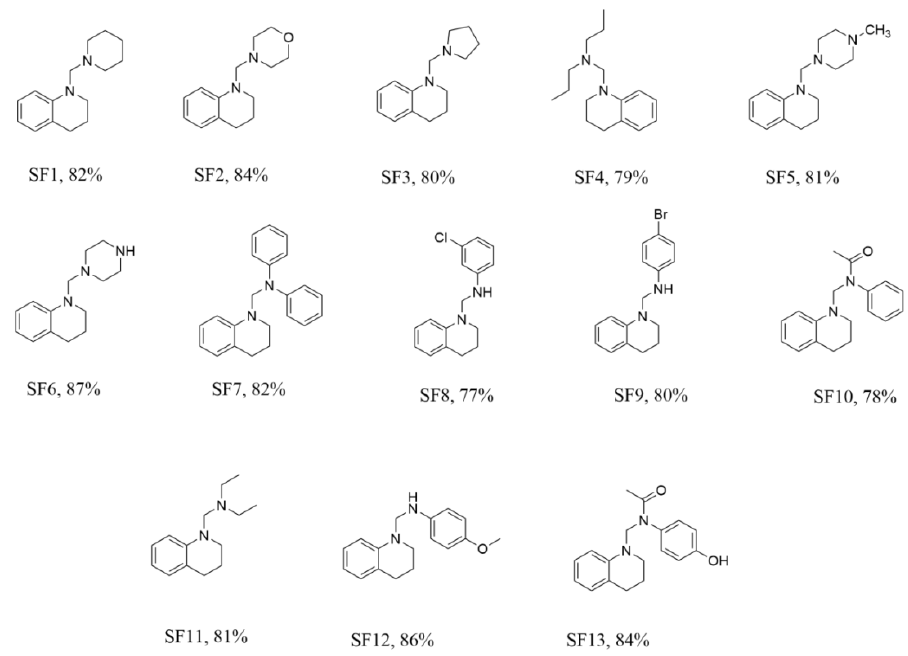
Scheme 4. Synthesis of compounds SF1 – SF13 . Reaction conditions: S (2.0 equiv), 1 – 13 (1.0 equiv), F (1.0 equiv); 3 mL solvent, conc. HCl 2 mol %, 80 °C (oil bath). Yields obtained after purification of product.